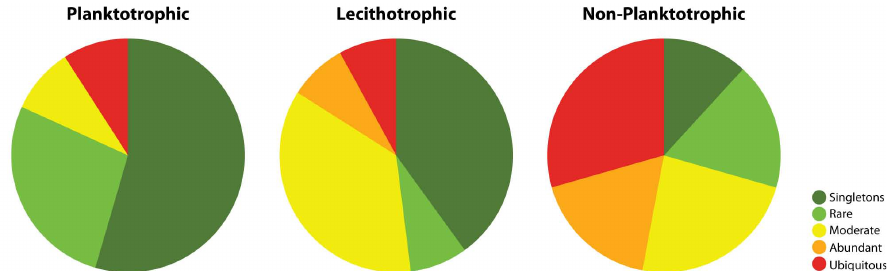
Fig. 5. Distributional patterns of Gulf of Cadiz deep-sea gastropod taxa with distinct larval development types. See text and Supplementary Table 2 for explanation of distributional categories and larval development